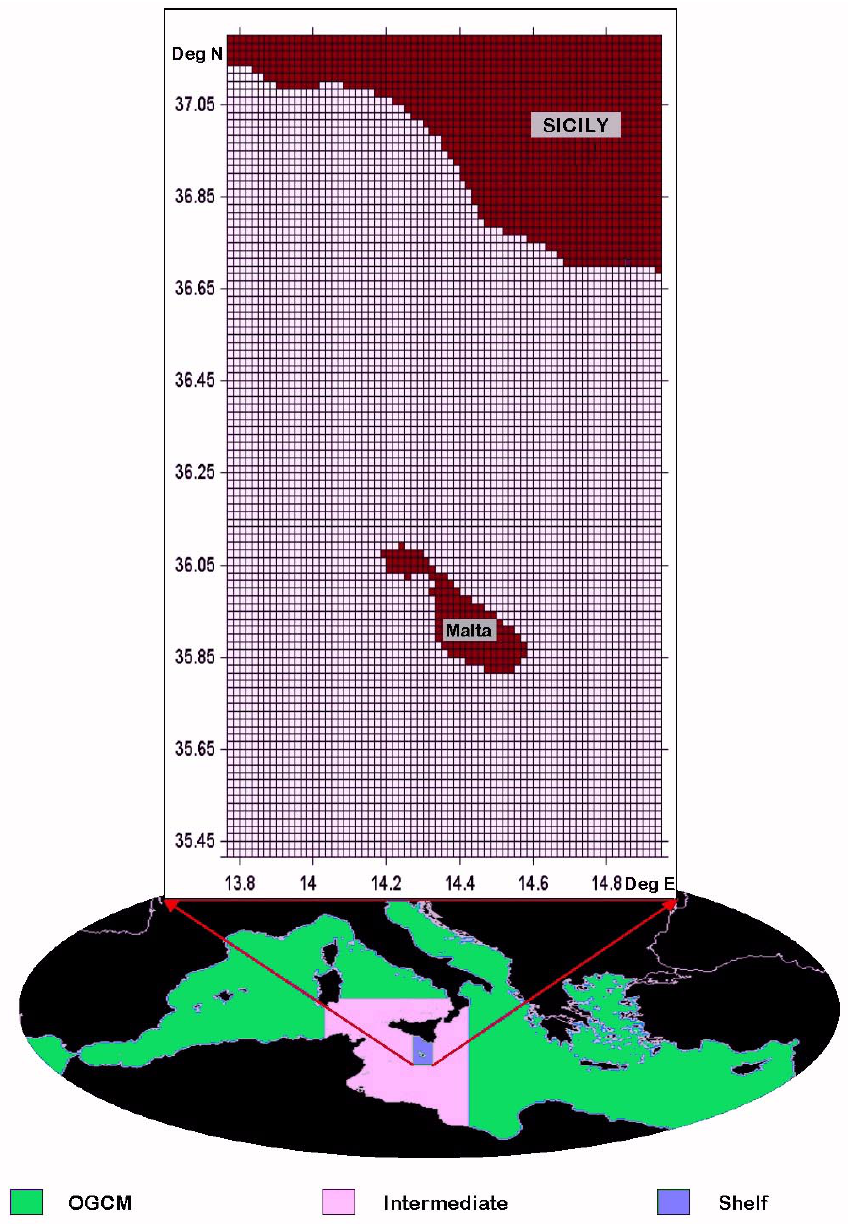
Fig. 2. The model gridded domain and its nesting to the intermediate model and the Ocean General Circula- tion Model of the